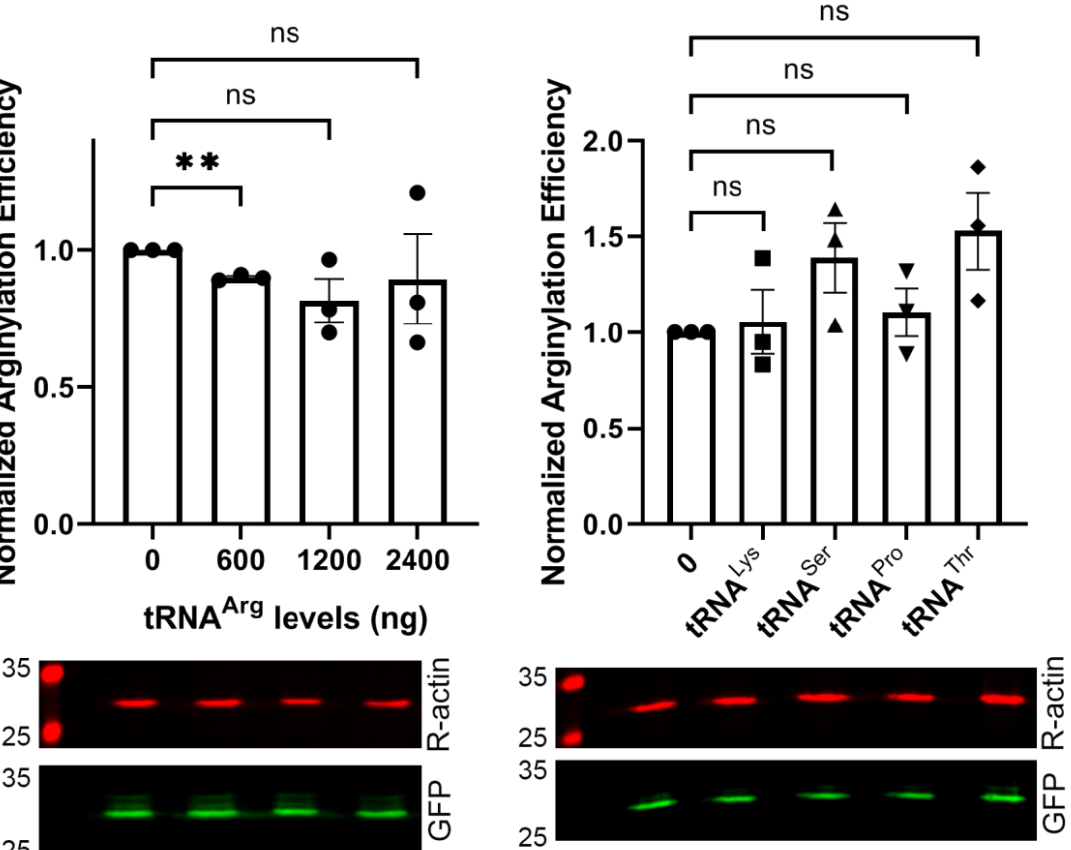
Figure 3. Transfection of cells with different tRNA species does not significantly affect intracellular arginylation. Charts ( top ) and representative Western blot images ( bottom ) of sensor-based quan- tification of arginylation in cells transfected with different amounts of tRNA Arg ( left ) or 1200 ng of different tRNA species as indicated ( right ). Error bars represent SEM, n = 3 independent transfections; ** p < 0.01; ns, not significant; Welch’s t